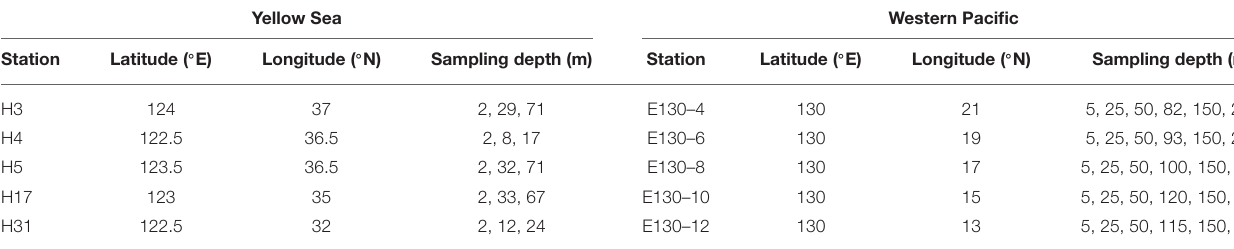
TABLE 1 | Information of sampling stations and depths for the Chl a analysis during the two cruises. Yellow Sea Western Pacific Station Latitude ( ◦